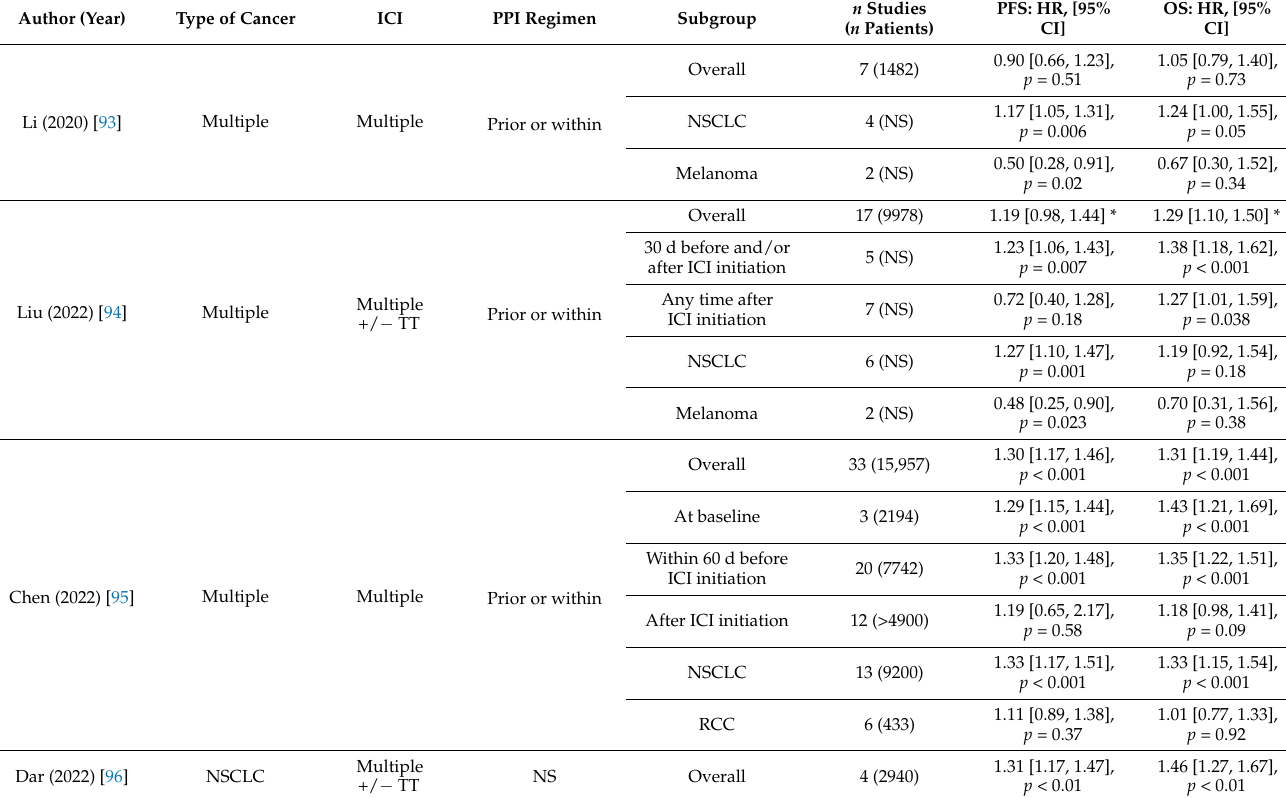
Table 6. Systematic reviews and meta-analyses on the impact of proton pump inhibitors on ICI treatment survival